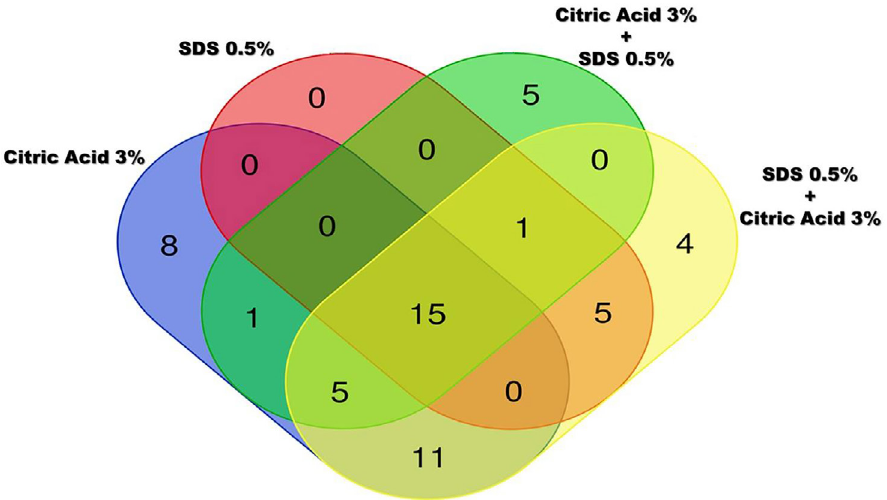
Figure 1- Venn Diagram with the numbers of the exclusive proteins from each group and the proteins common to two or more